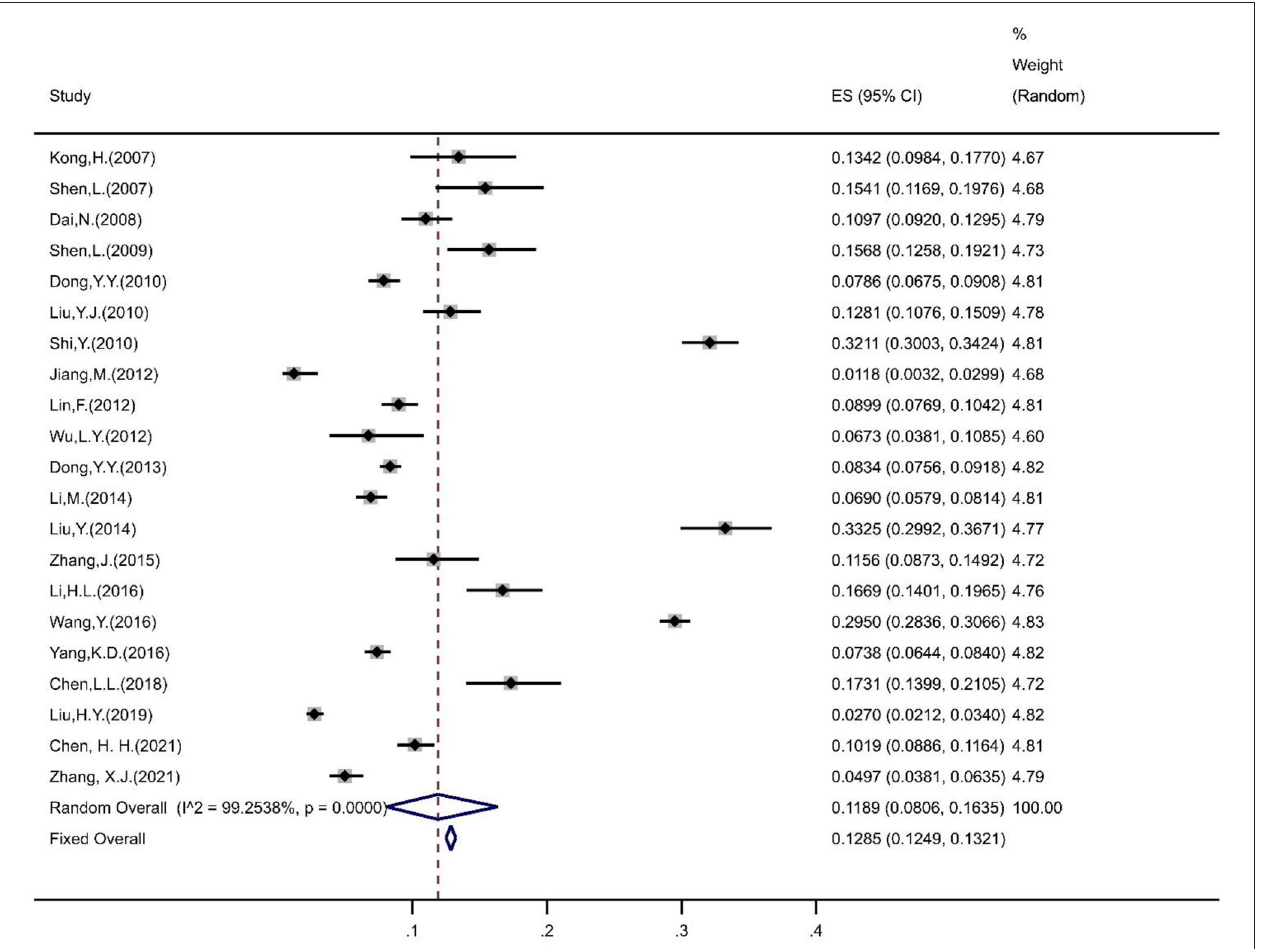
FIGURE 2 | Forest plot of prevalence of IBS in Chinses university students. ES, effect